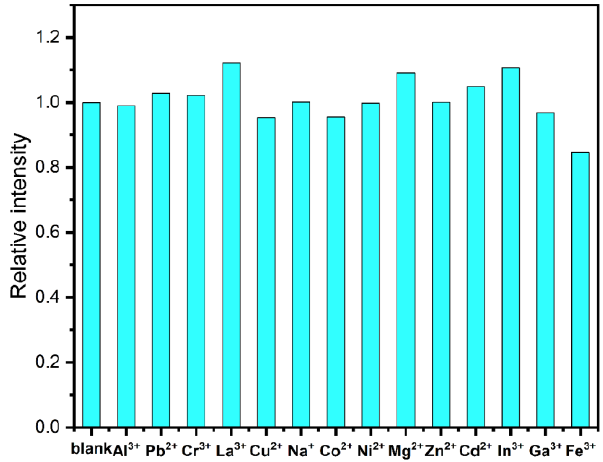
( b ) Figure 3. Excitation and emission photoluminescence spectra of MOF 1 : ( a ) in the solid state; ( b ) in ethanol suspension. Investigation of the stability of MOF 1 upon soaking in different solvents revealed that it was stable in common organic solvents but degraded in water (vide supra). Out of the tested solvents, ethanol was chosen as a dispersion medium for luminescent sensing studies as an inexpensive and an environmentally neutral option. 3.3.1. Metal Ion Detection The possibility of detecting metal ions with coordination polymers containing the 2,1,3-benzothiadiazole fragment was discussed in several recent papers [18,42 – 47]. To test the sensing ability of MOF 1, its photoluminescence spectra in ethanol suspension were recorded in the presence of different metal cations as 0.1 mM nitrate solutions in ethanol. The luminescence intensity was practically independent from the presence of most metal cations except Fe 3+ (Figure 4). The addition of Fe 3+ resulted in only a slight luminescence-